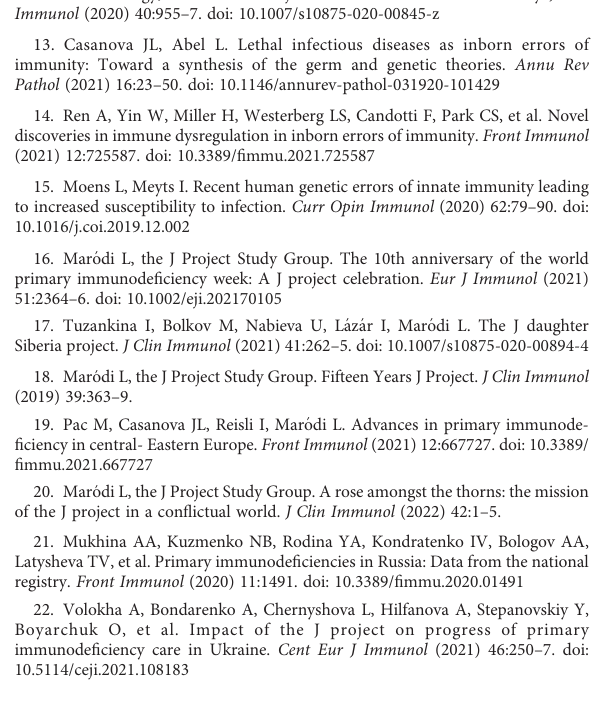
SUPPLEMENTARY FIGURE 3 Pie diagram showing the percentages of various inborn errors of immunity subgroups of patients reported to the J Project. SUPPLEMENTARY FIGURE 4 The fi rst 8 J Project meetings organized in Central